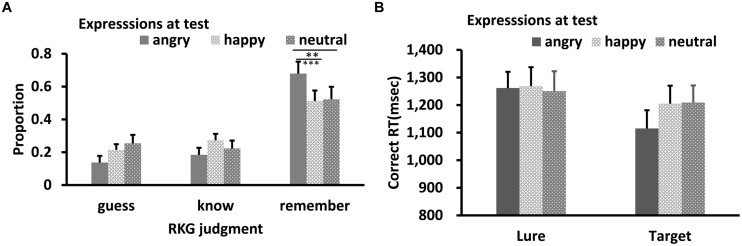
RKG judgment (A) and Correct RT (B) as a function of test expression (Experiment 2b). Error bars represent 1 SEM. ∗∗p < 0.01; ∗∗∗p < 0.001.